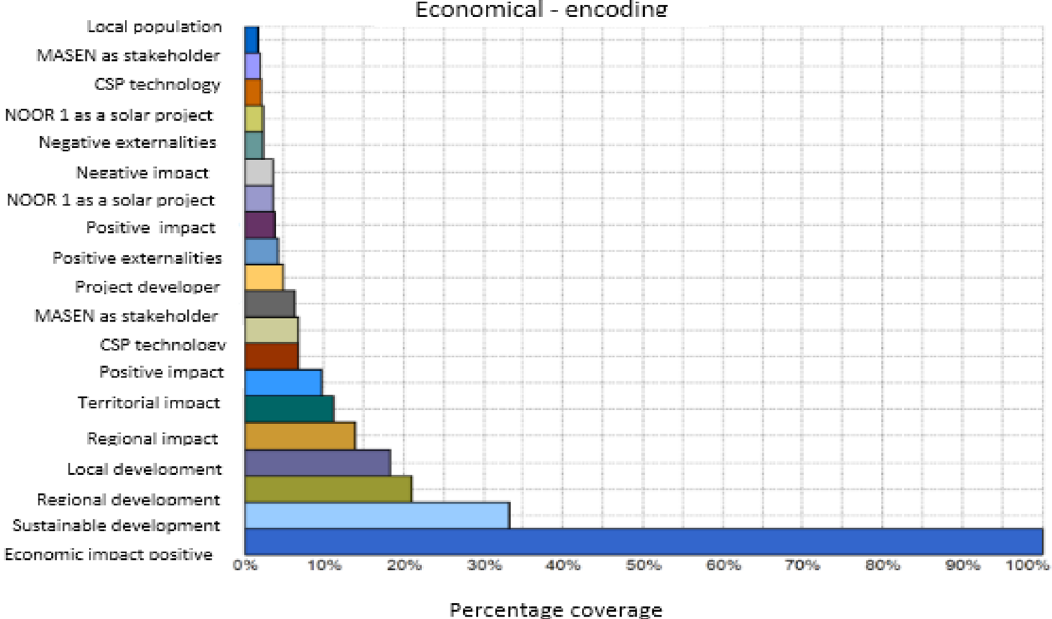
Fig. 2. Encoding by source (cid:3) economic